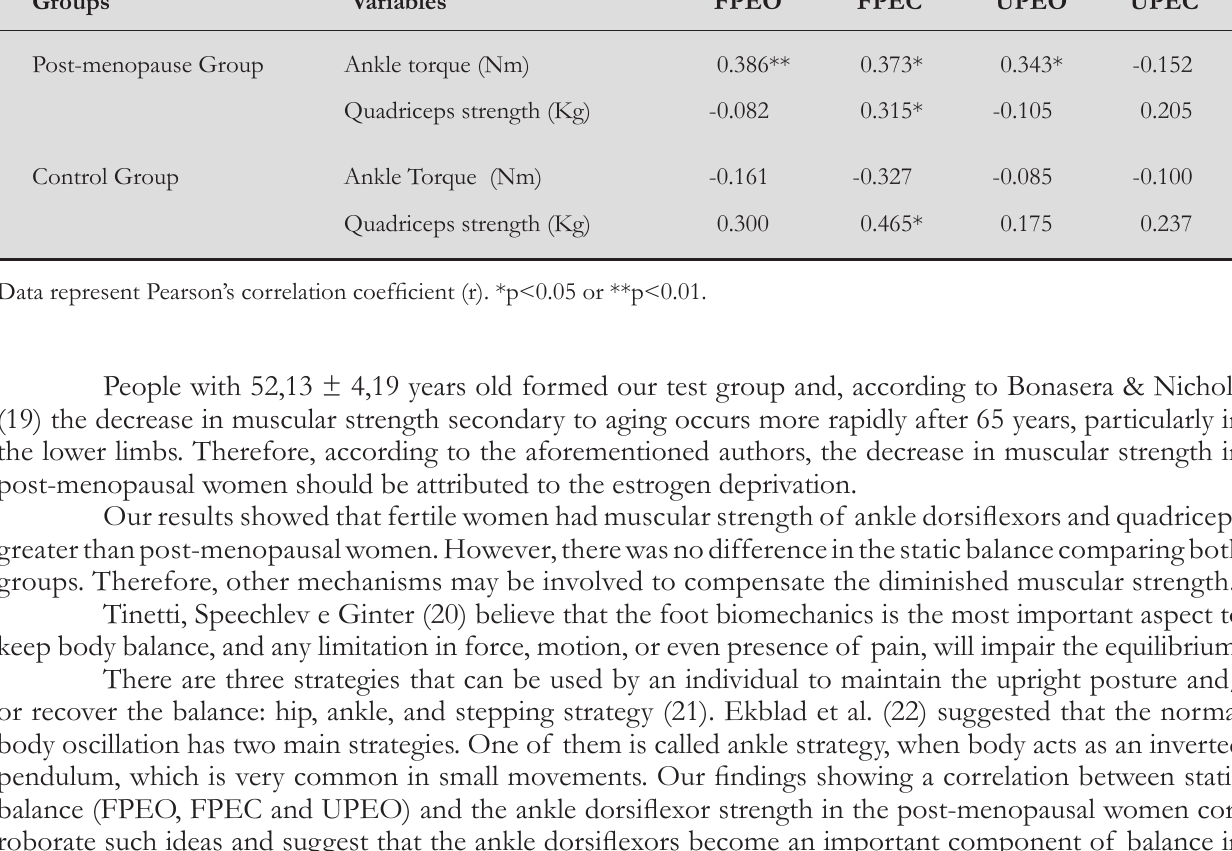
Table 2 - Correlation between ankle torque, quadriceps strength and static balance